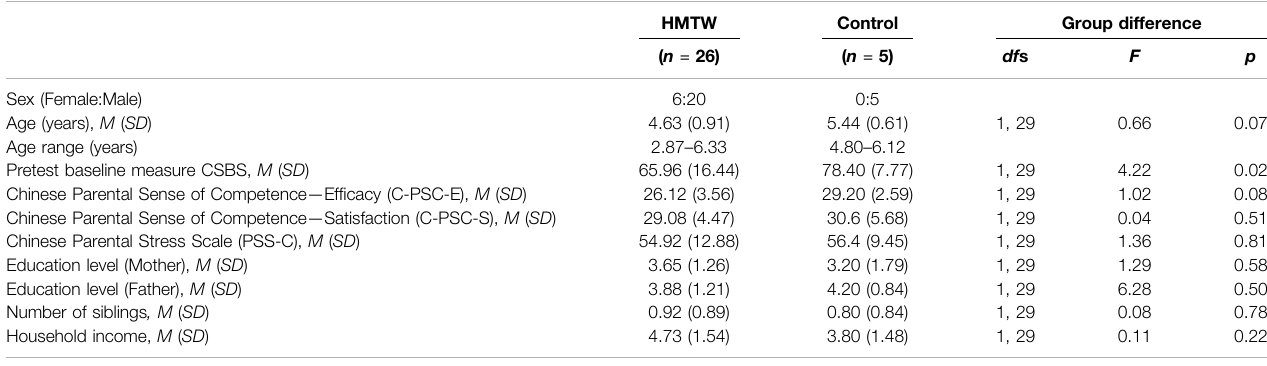
TABLE 1 | Participants ’ characteristics and pretest scores.